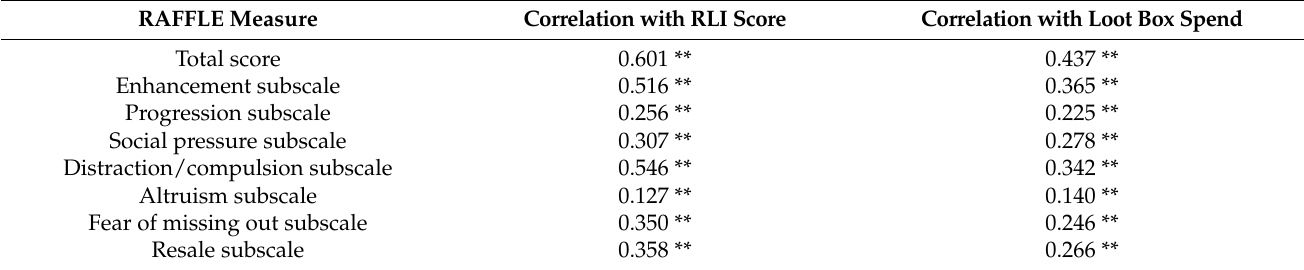
Table 4. Correlations (Spearman’s rho) between RAFFLE scores and other measures of loot box engagement. RAFFLE Measure Correlation with RLI Score Correlation with Loot Box Spend Total score 0.601